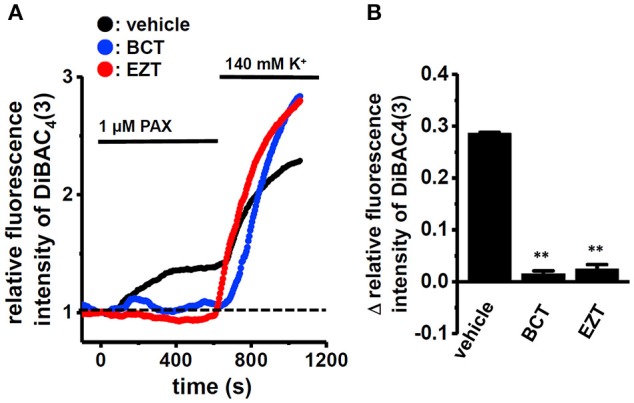
Effects of treatments with antiandrogens for 48 h on 1 μM paxilline (PAX)-induced depolarization responses in MDA-MB-453 cells. (A) Measurement of PAX-induced depolarization responses in vehicle (black symbols)-, BCT (blue symbols)-, and EZT (red symbols)-treated MDA-MB-453 cells. The fluorescence intensity of DiBAC4(3) before the application of PAX at 0 s is expressed as 1.0. The time courses of changes in the relative fluorescence intensity of DiBAC4(3) are shown. (B) Summarized data are shown as the PAX-induced Δ relative fluorescence intensity of DiBAC4(3) in vehicle-, BCT-, and EZT-treated MDA-MB-453 cells. Cells were obtained from three different batches (59, 60, and 47 cells in each group). Results were expressed as means ± SEM. **p <0.01 vs. the vehicle control.